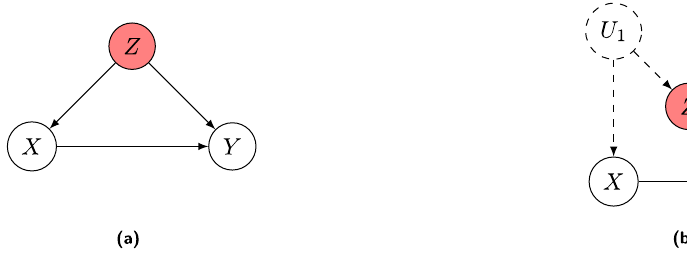
Figure 5: Potential models explaining Simpson ’ s paradox. ( a ) Observed confounder Z between X and Y . ( b ) M - graph with unobserved confounders U 1 and U 2 between X Z , and Z Y ,